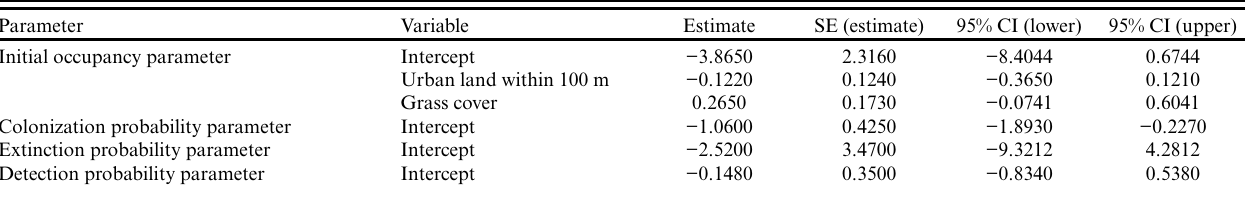
Table 4. Highest ranking multiseason occupancy model for Le Conte’s Sparrow along 47 transmission line study sites in Winnipeg, Manitoba, Canada in 2008–2009. AICc = 147.50, Δ AICc = 0.00, AIC weight = 0.29 N = 276 surveys. Total Mackenzie-Bailey chi-